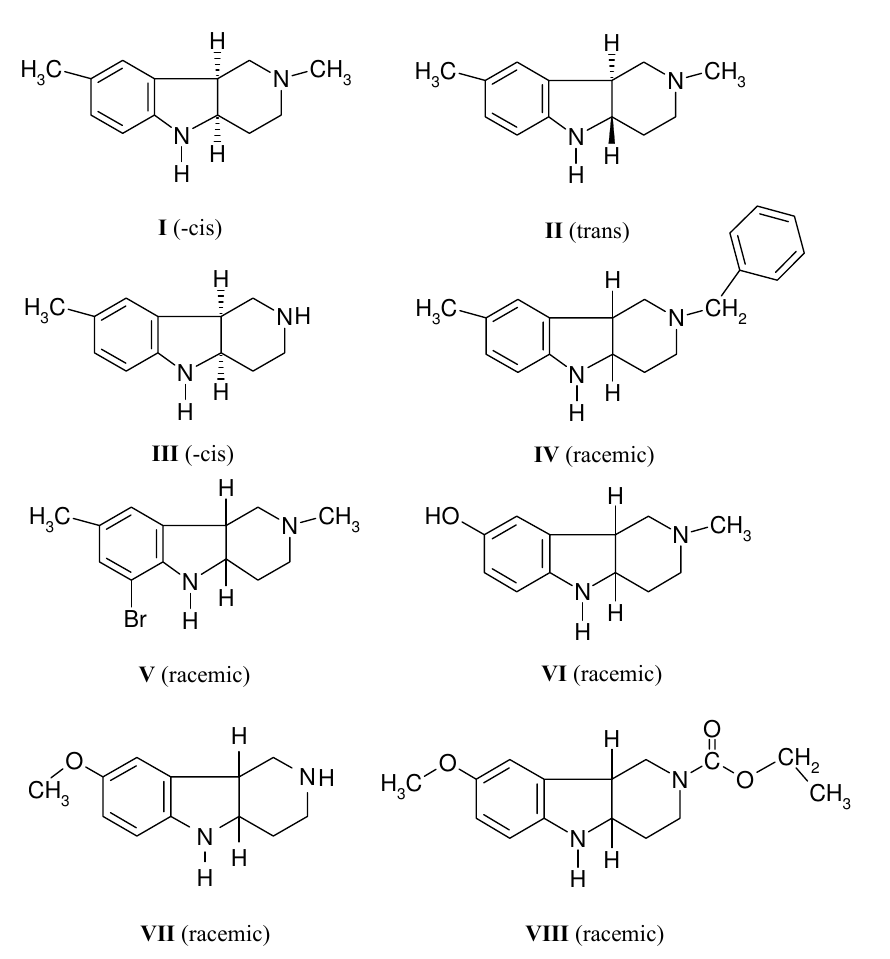
Fig. 1 Identification of the studied pyridoindole